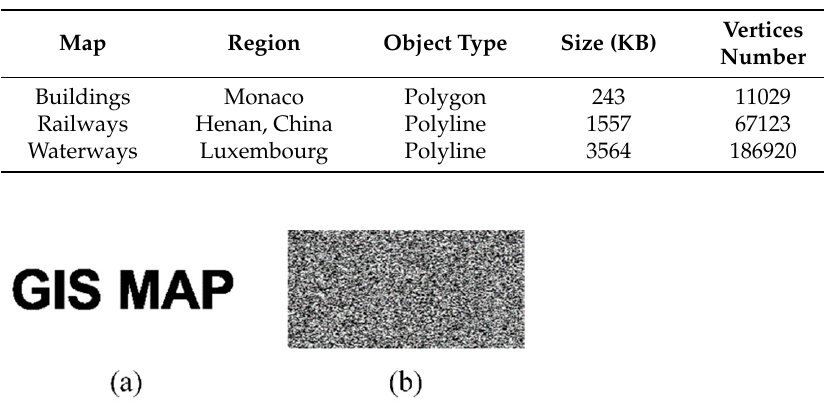
Figure 5. Original vector maps data: ( a ) buildings, ( b ) roads, ( c ) waterways. Table 1. The detailed information of the GIS vector map data.